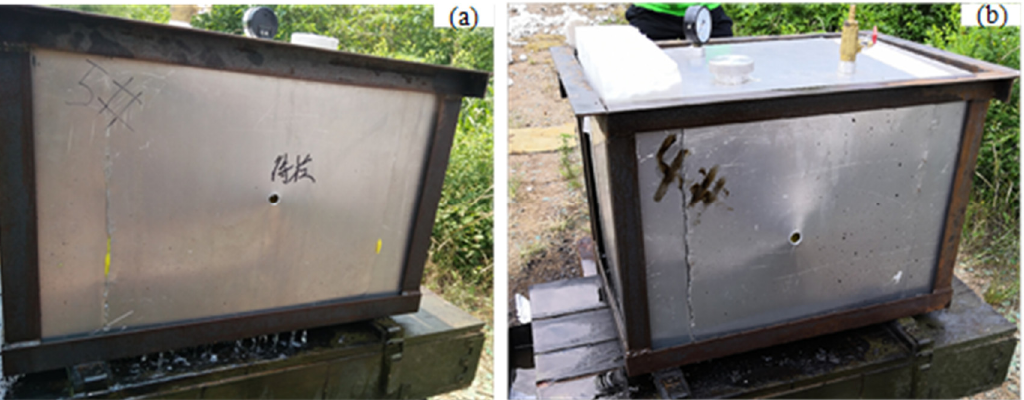
Figure 9. Damage to the fuel tank caused by small-mass energetic fragments. ( a ) Damage to the fuel tank caused by the 3.3 g energetic fragments; and ( b ) damage to the fuel tank caused by the 5 g energetic fragments.